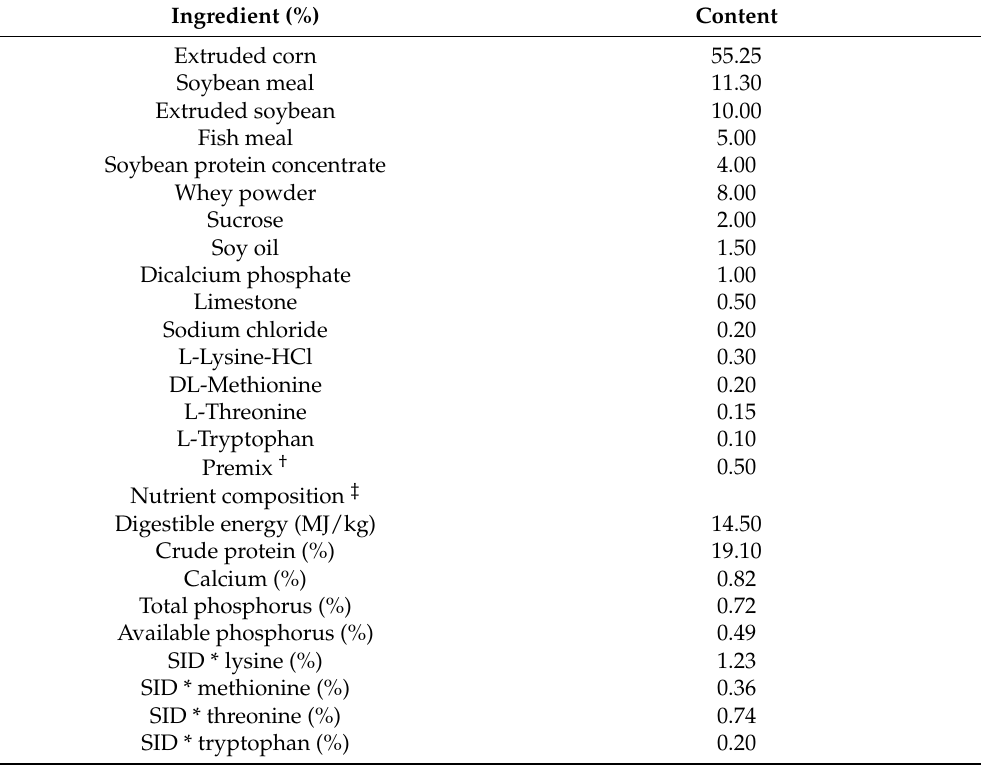
Table 1. Ingredients and chemical composition of experimental diets (as-fed